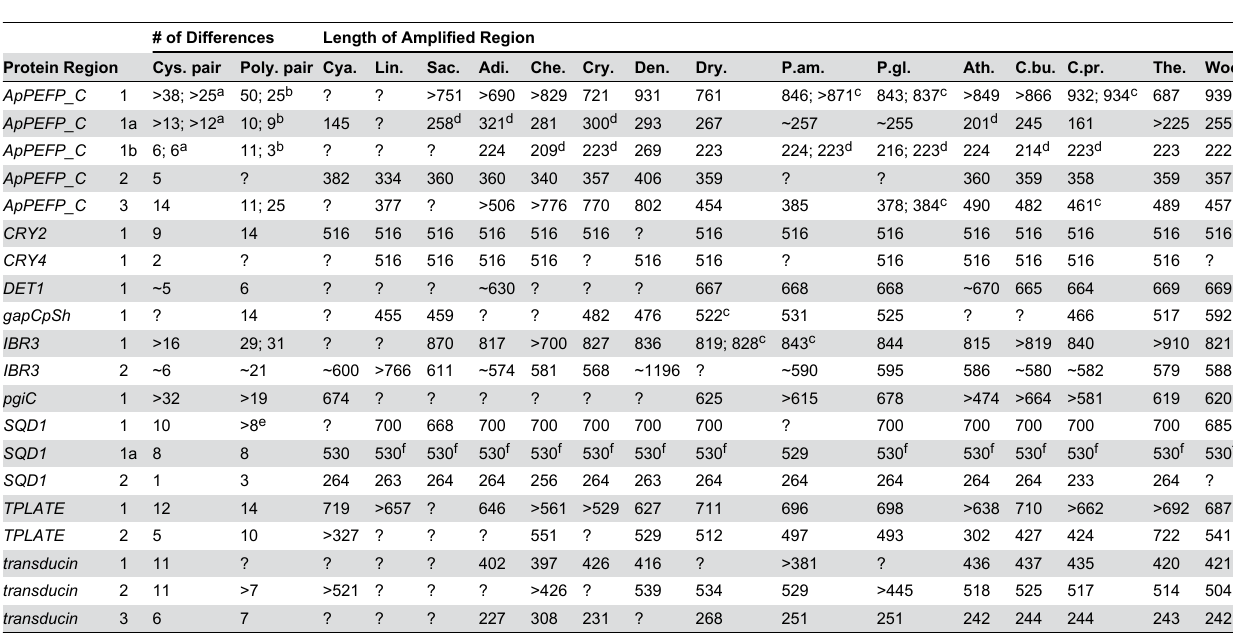
Table 3. Sequence characteristics for the single-copy regions developed in this study.